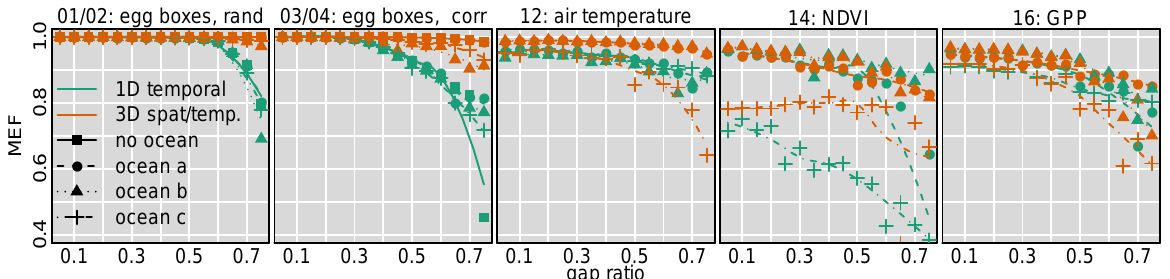
Fig. 6. Prediction performance of the 2-D spatiotemporal gapfilling scheme in comparison to the state-of-the-art (1-D temporal) SSA method. Solid or dashed lines were obtained using a loess smoother for each scenario and dataset.